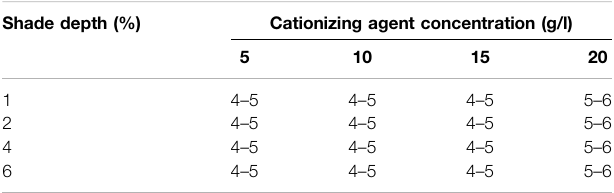
TABLE 3 | Colorfastness to light results of cationized cotton dyed samples recorded according to the AATCC TM16 in Q-SUN XE-2 Xenon test chamber for 72 h.